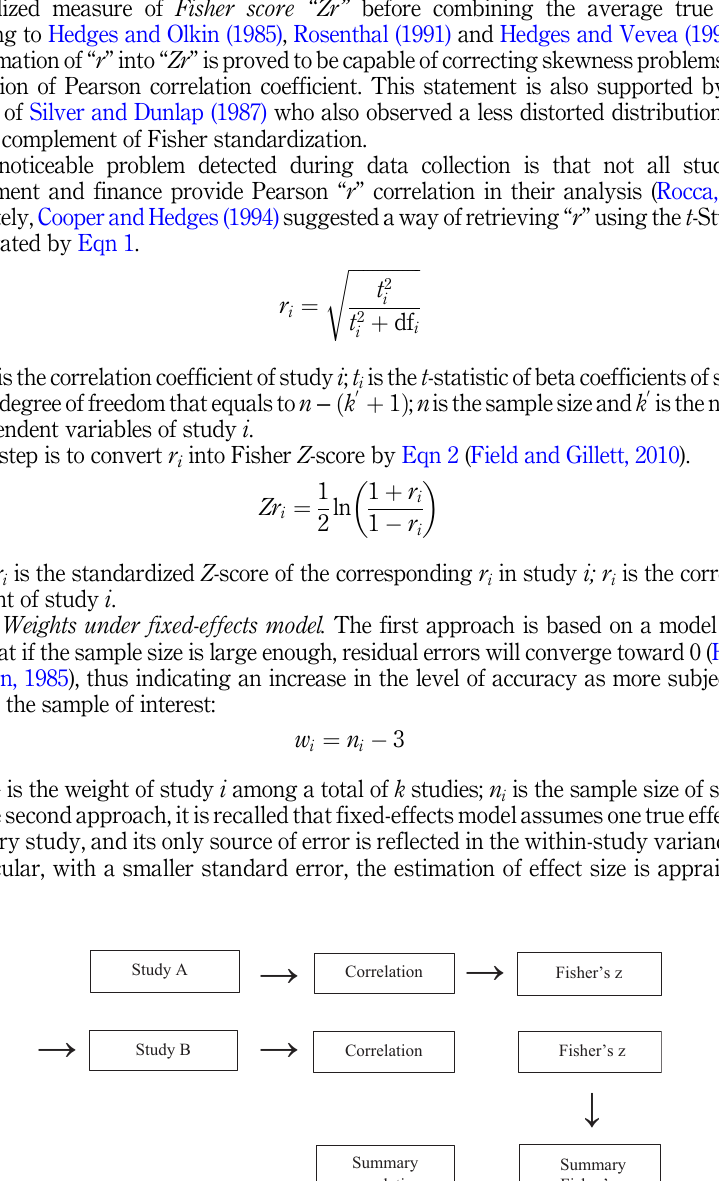
Figure 1. Procedure to analyze overall effect size on